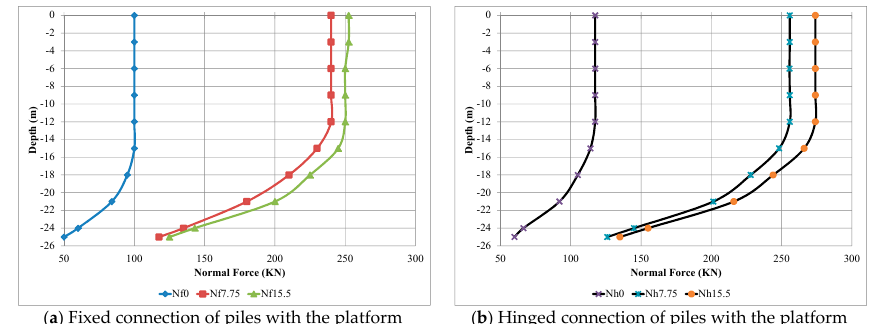
Figure 7. Normal forces acting on the selected piles P1, P2, and P3 with a fixed and hinged pile-platform connection.